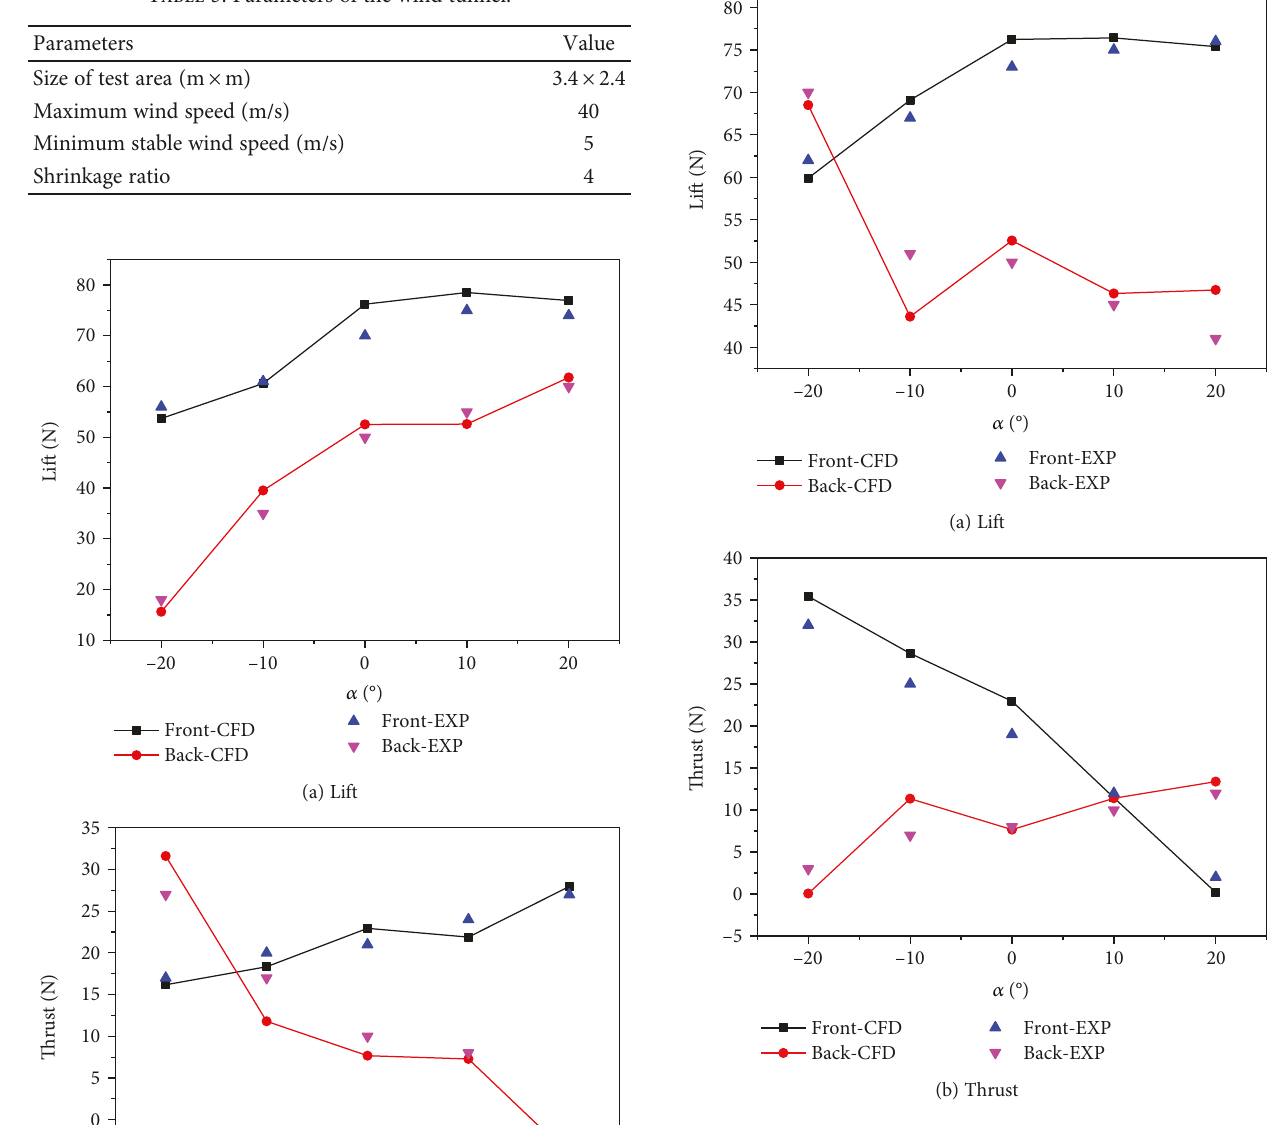
Figure 22: Comparison curves between numerical results and experimental results when the rear wing is fi